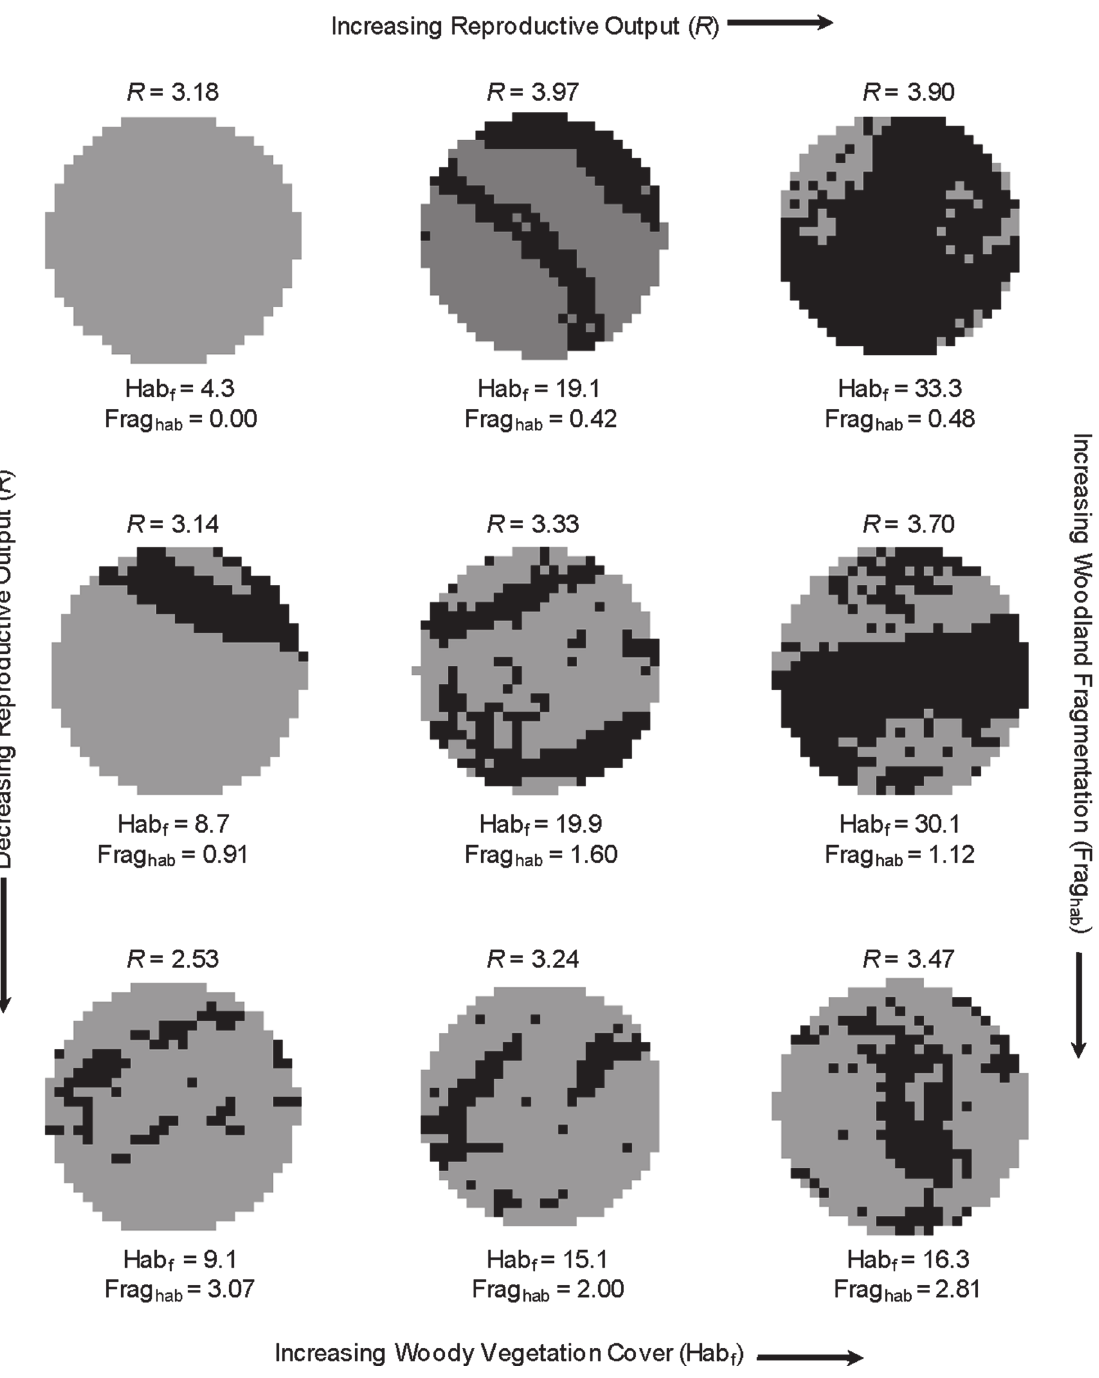
Fig 4. Effects of habitat frgamentation (Frag hab ) and quantity of woodland vegetation cover (Hab f ) on reproductive output ( R ) of ferruginous pygmy-owls in northwest Mexico, 2001 – 2010. The 9 territory patches shown all have high abundance of potential nest sites and were selected to illustrate effects. Black pixels (30-m) had (cid:3) 20% woody vegetation cover and were classified as woodland and gray pixels had < 20% woody vegetation cover. Estimates of R are based on model 3 in Table 3.